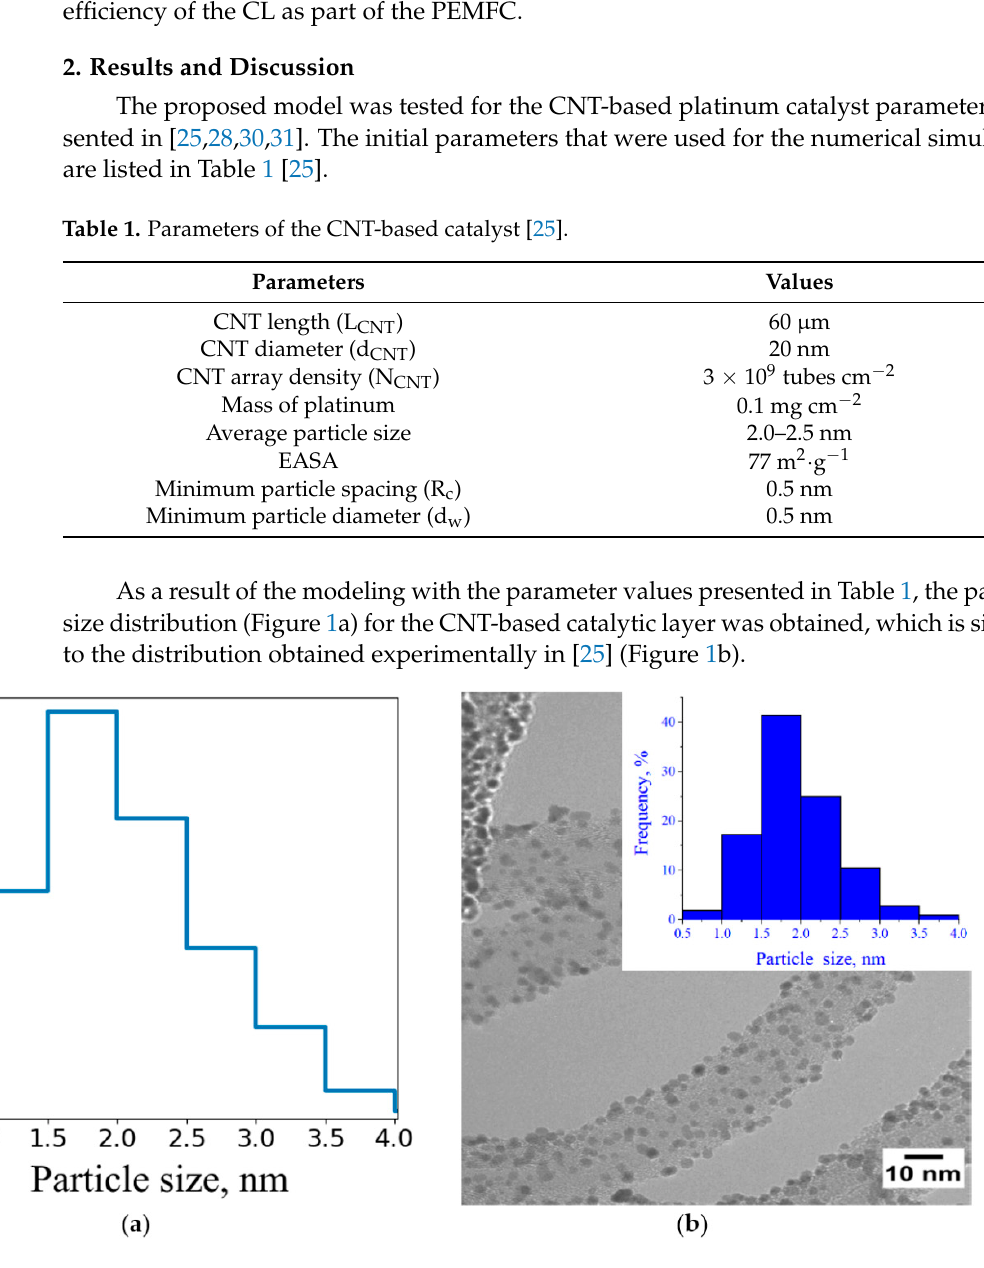
Figure 1. Particle size distribution obtained from the numerical simulation ( a ) and results of the TEM image processing [25] ( b ). image processing [25] ( b